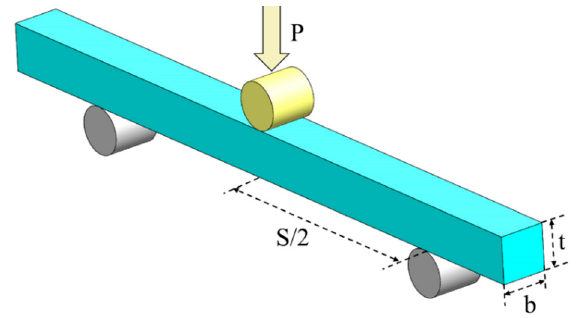
Figure 1. The schematic of samples and fatigue test mode.